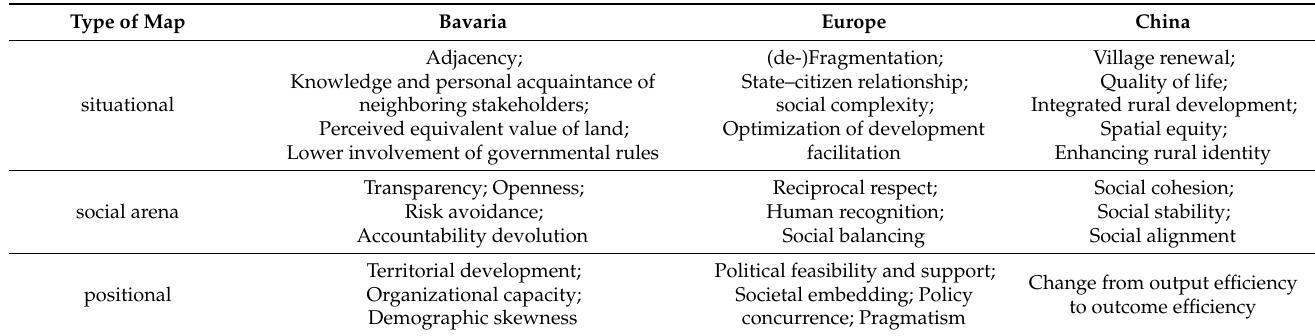
Table 1. Situational analysis of land consolidation